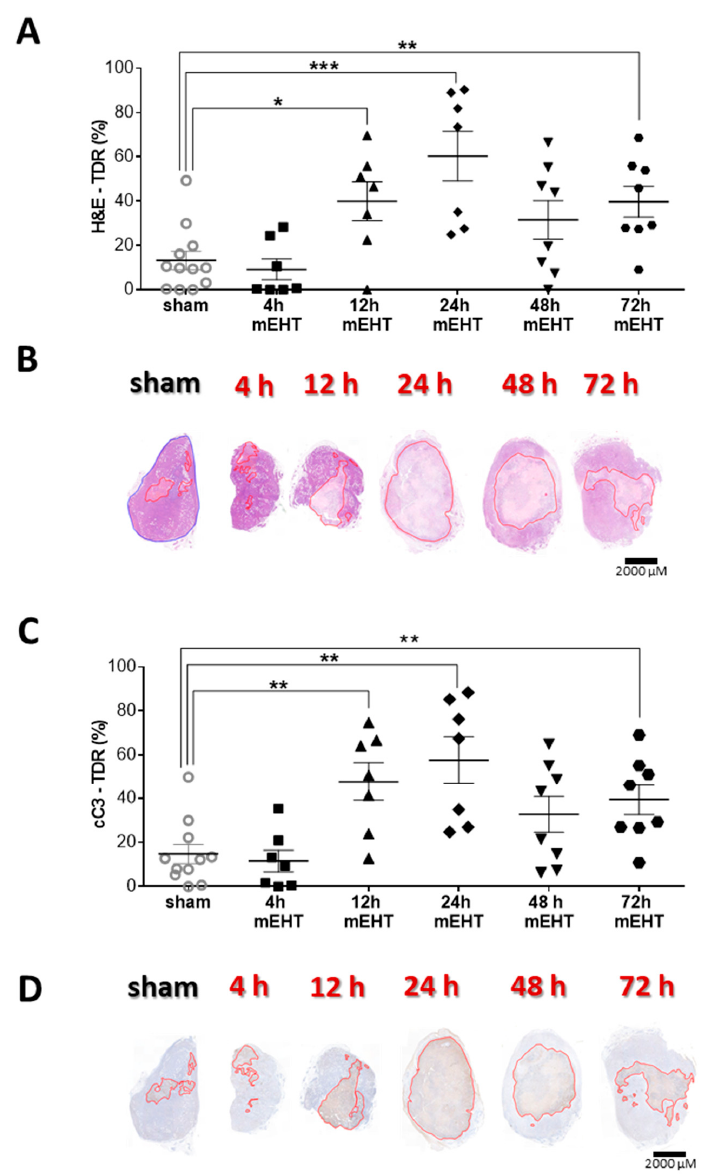
Figure 9. Time kinetics of tumor tissue destruction after mEHT. ( A ) Quantification of tumor destruction ratio (TDR %) on hematoxylin-eosin (H&E)-stained tumors; ( B ) Representative images of H&E-stained sections from sham and mEHT-treated tumors from 4, 12, 24, 48, and 72 h after 3 treatments. Red lines mark the damaged area; ( C ) Quantification of TDR % on cC3 stained sham and mEHT treated tumors; ( D ) Representative images of cC3-stained sections from sham- and mEHT-treated tumors. Red lines mark the damaged area; ( A , C ) unpaired Mann–Whitney test. Mean ± SEM, n = 6–12/group, * p < 0.05, ** p < 0.01, *** p < 0.001.